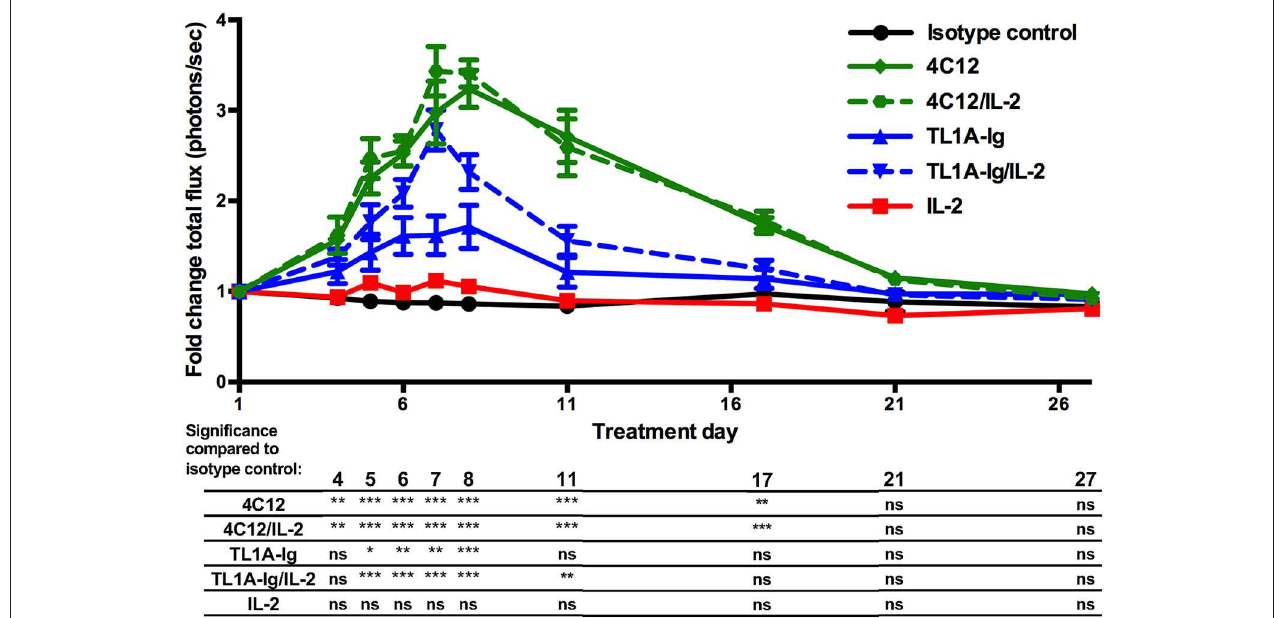
FIGURE 2 | Kinetics of in vivo expansion of regulatory T cells through activation of the death receptor 3 pathway. Mice expressing luciferase under control of the FoxP3 promoter were treated with agonists of the DR3 pathway and regulatory T cell expansion was analyzed via bioluminescent imaging as in Materials and Methods. (Shown are the mean and SEM for each group ( n = 8) over time. * p < 0.05, ** p < 0.01, and *** p < 0.001 as compared to isotype control antibody treatment, two-way ANOVA with matched values and Bonferroni correction for multiple comparisons). Results are combined from 2 independent